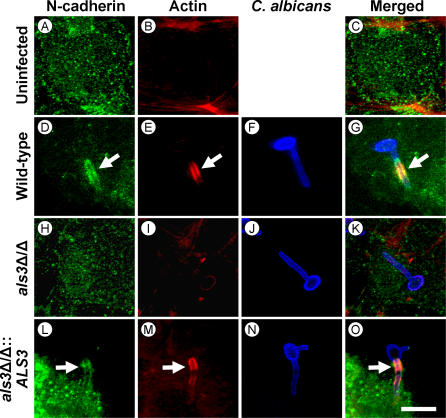
Endothelial Cell N-Cadherin Colocalizes with Wild-Type C. albicans, but Not an als3Δ/als3Δ Mutant StrainConfocal micrographs of uninfected endothelial cells (A–C), or endothelial cells infected with the wild-type strain (D–G), the als3Δ/als3Δ null mutant (H–K), or the als3Δ/als3Δ::ALS3-complemented strain (L–O). The cells were stained for N-cadherin (A), (D), (H), and (L), actin microfilaments (B), (E), (I), and (M), and C. albicans (F), (J), and (N). The merged images are shown in (C), (G), (K), and (O). Arrows indicate the accumulation of N-cadherin and microfilaments around the organisms. Bar in (O) indicates 10 μm.